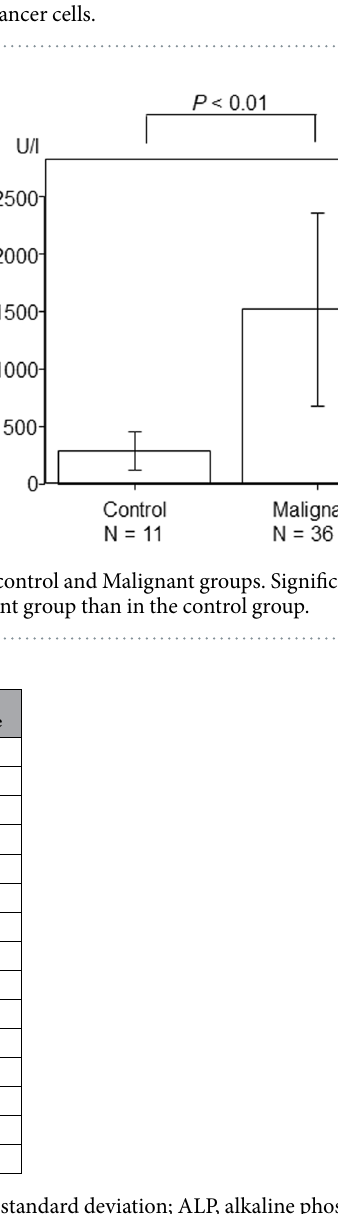
Figure 1. Expression of cytokeratin M30 in a patient with biliary ductal cancer. ( a ) (HE x200), ( b ) (M30 x200). M30 expression was observed in the cytoplasm of biliary ductal cancer cells.